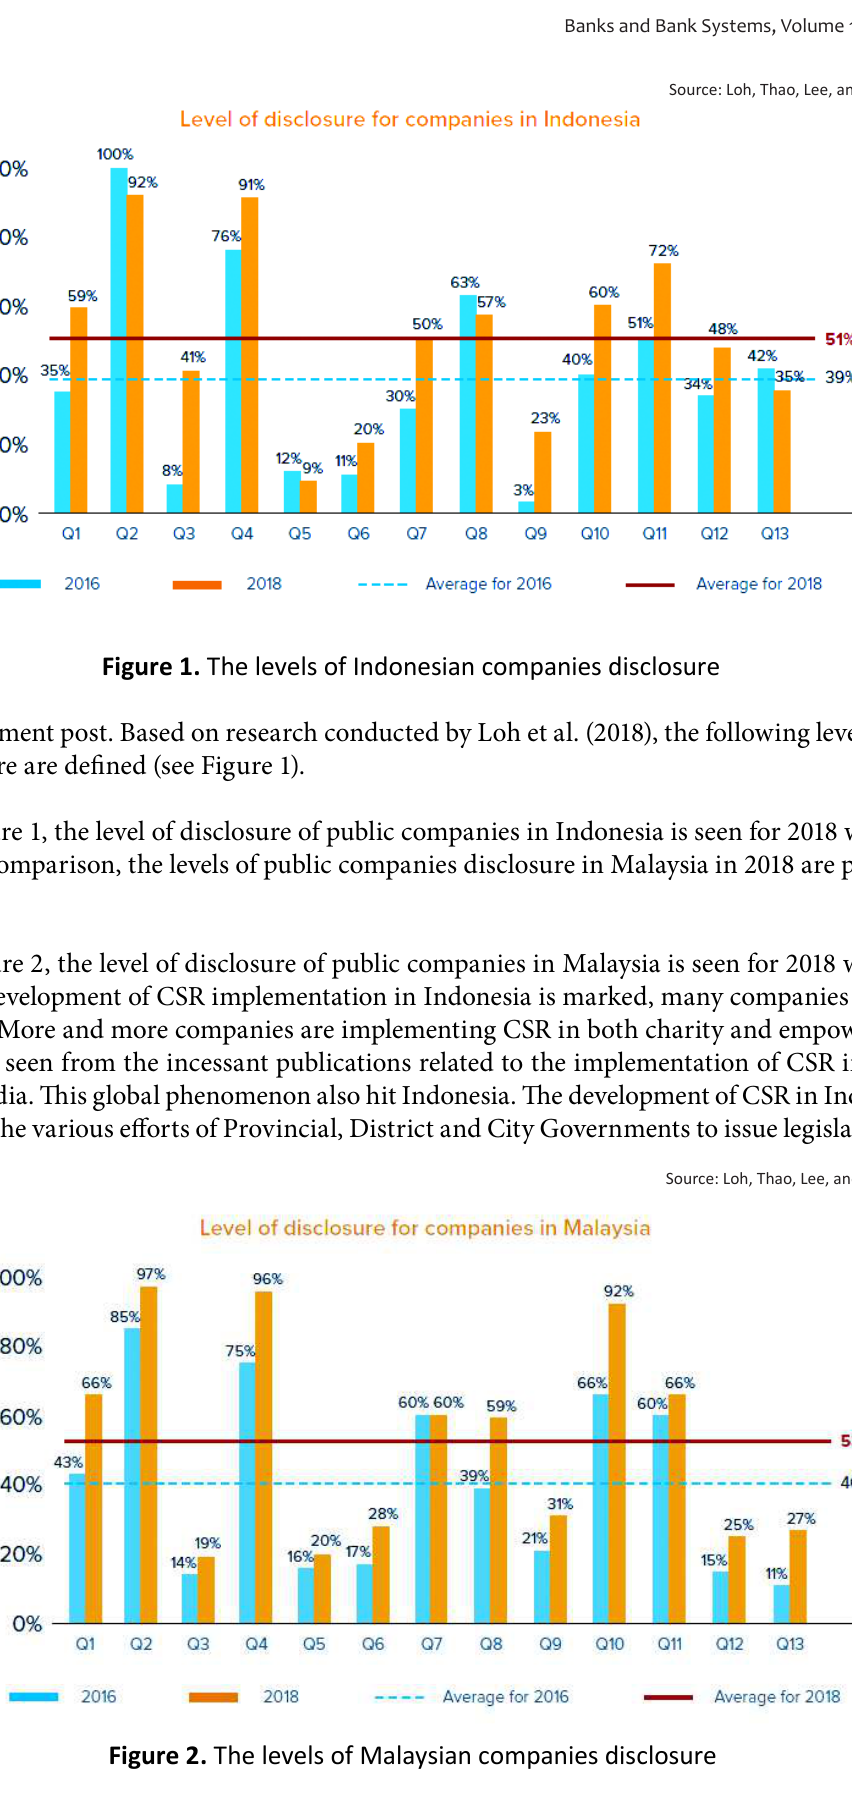
Figure 2. The levels of Malaysian companies disclosure